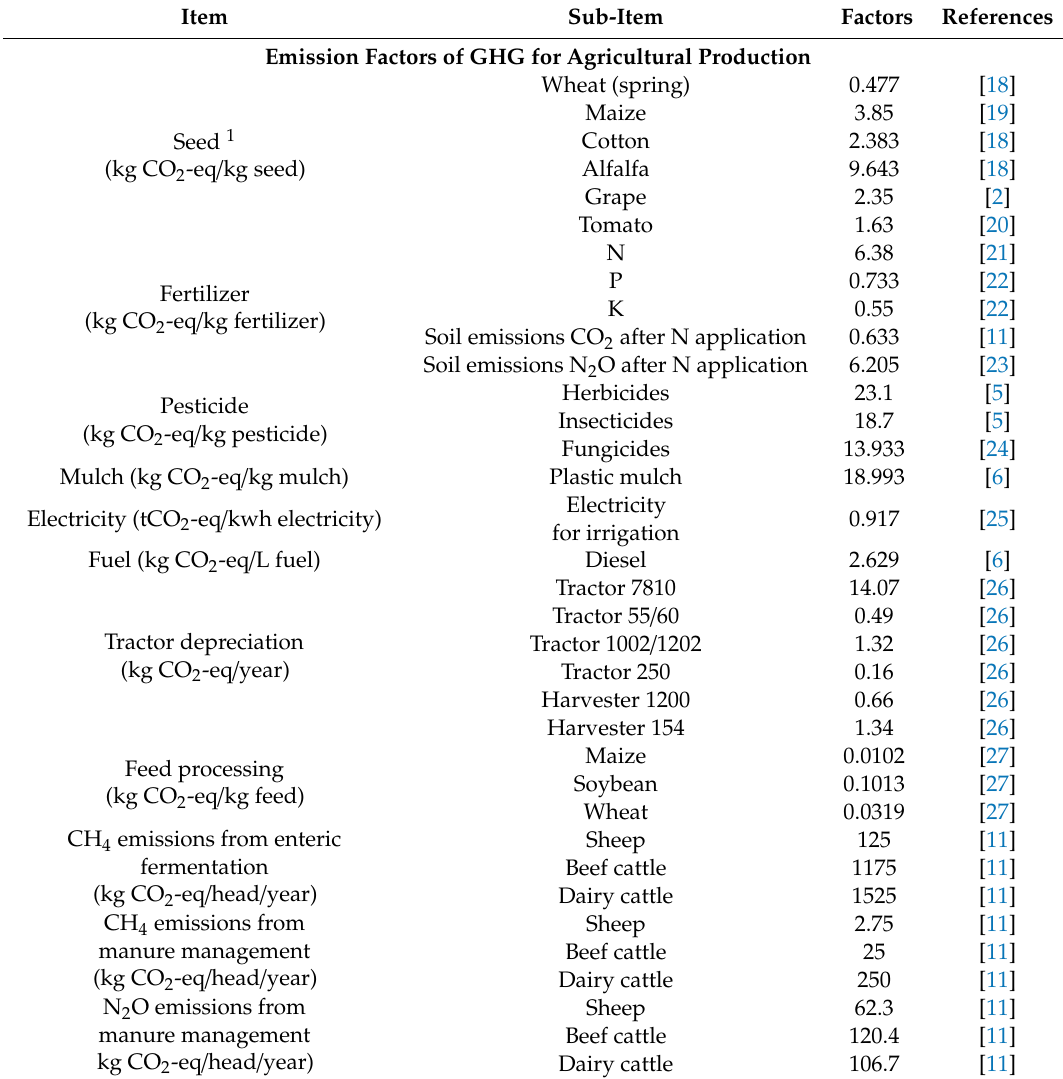
Table 2. Factors used for the calculation of GHG